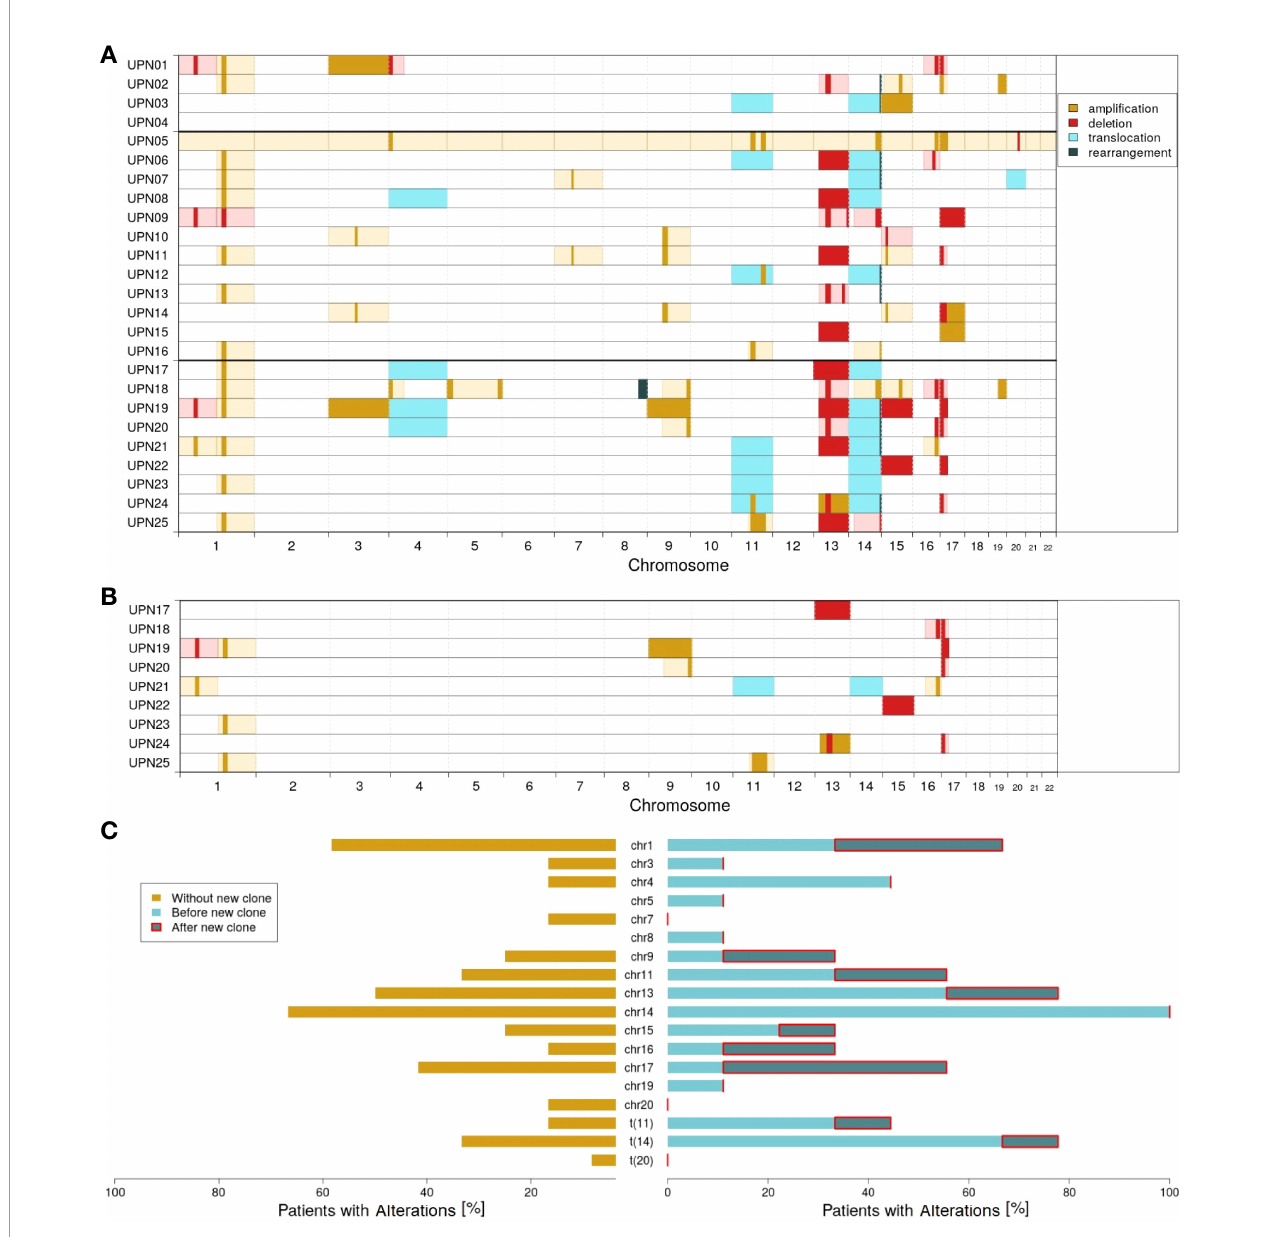
FIGURE 2 | Molecular characterization of the cohort; ampli fi cations (dark yellow), deletions (red), translocations (light blue), and rearrangements (dark green) according to FISH probes. Light colors (yellow and red) indicate likely interpretation of the observed FISH results. (A) Overview of all alterations detected. (B) Alterations characterizing the new clones observed in patients UPN17 to 25. (C) Proportion of patients with altered chromosomes: without the new clone (dark yellow), with the new clone before (light blue), and after (dark blue) detection of the new